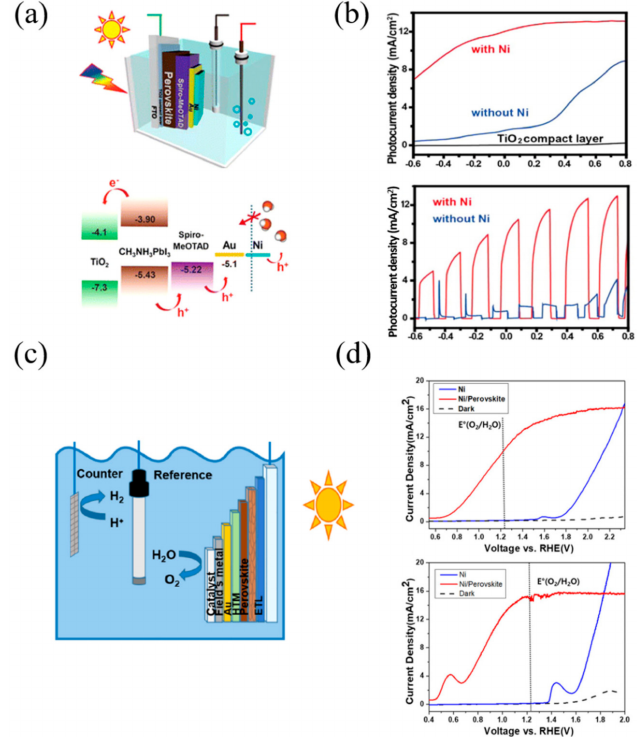
Figure 4. Examples of the n–i–p configuration of perovskite-based PEC cells. ( a ) Schematic illustration of the photoelectrochemical test of a Ni-coated perovskite photoanode in a PEC cell using a standard three-electrode system and energy diagram of each material. ( b ) Photocurrent densities of the compact TiO 2 layer (black curve) and CH 3 NH 3 PbI 3 photoanodes without (blue curve) and with Ni surface layer (red curve). Comparison of photocurrent densities of CH 3 NH 3 PbI 3 photoanodes (with and without Ni surface layer). ( c ) Schematic illustration of the integrated photoelectrolysis cell with perovskite photoelectrode. ( d ) Voltammogram of perovskite photoanode with 10 µ m Ni catalyst under simulated illumination (0.7 sun; red curve), under dark (dashed curve), and on metallic Ni electrode (blue curve) as reference. Electrolyte was K-borate solution (pH 9.2) and 1.0 M KOH solution (pH 14) respectively